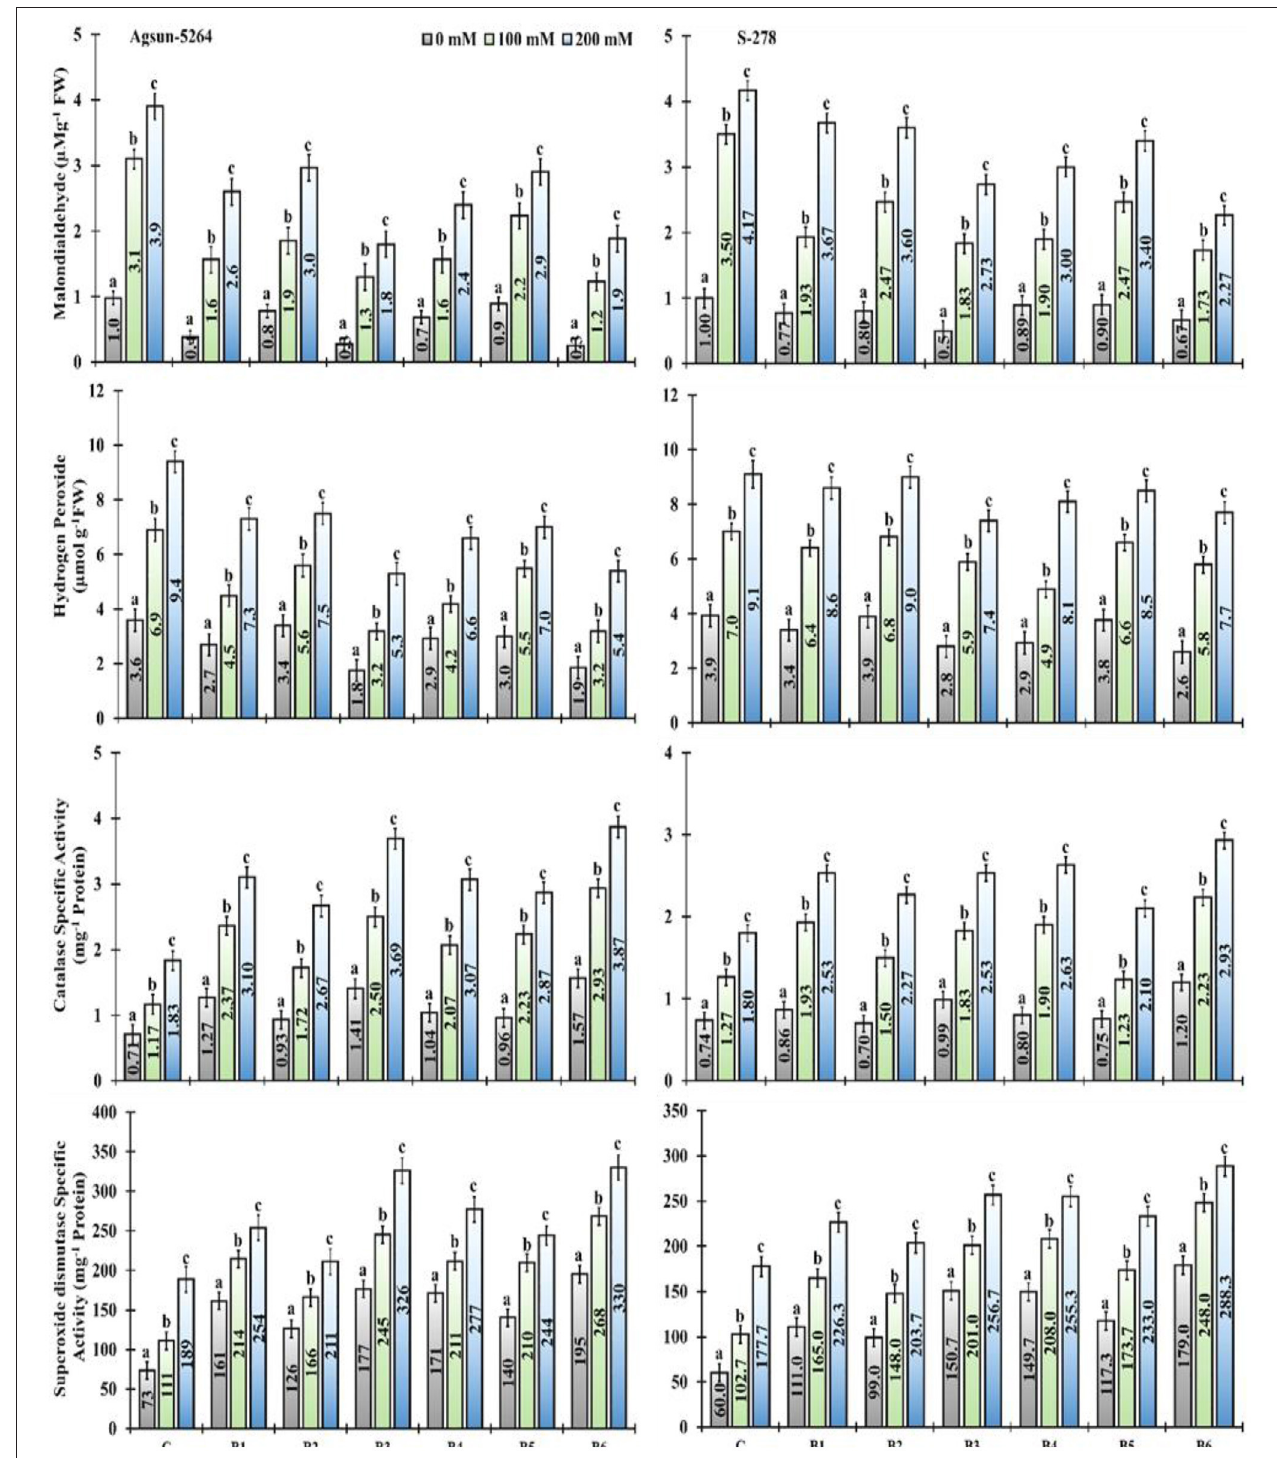
FIGURE 9 | Effect of halophilic microbial strains on changes in Malondialdehyde (MDA), Hydrogen peroxide (H 2 O 2 ), Catalase specific activity (CAT), and Superoxide dismutase specific activity (SOD) of sunflower cultivars under salinity stress. Vertical line on the bar represents mean standard error (S.E). Similar alphabet shows non-significant difference at p ≤ 0.05 (Bonferroni post-hoc test) between treatments.